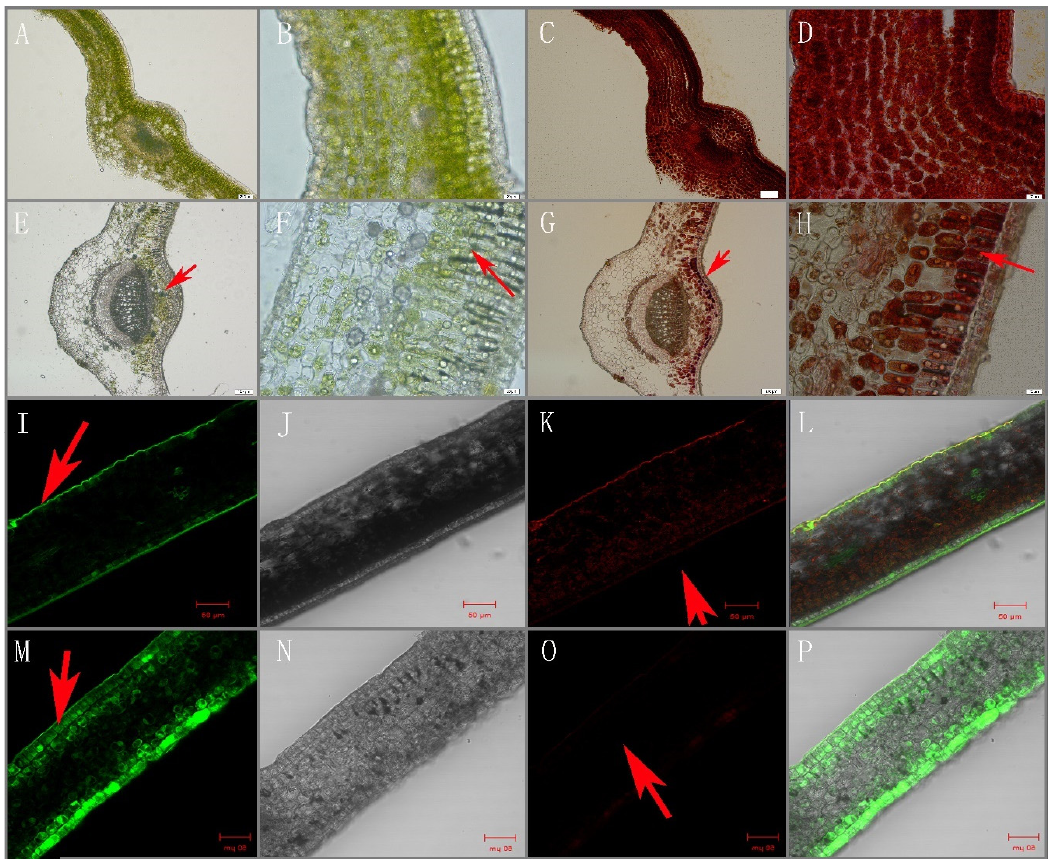
Figure 5. Distribution of catechin and dihydroxy flavonol in albino and green tea leaves of ‘Baiye 1